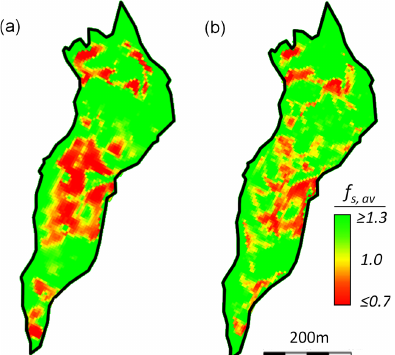
Fig. 6. The annually average factor of safety ( f s,av ) simulated for one year calibration period (2007) with the model (a) accounting for hydrological feedback only (first stage of calibration) and (b) accounting for both hydrological and mechanical feedbacks (second stage of calibration).